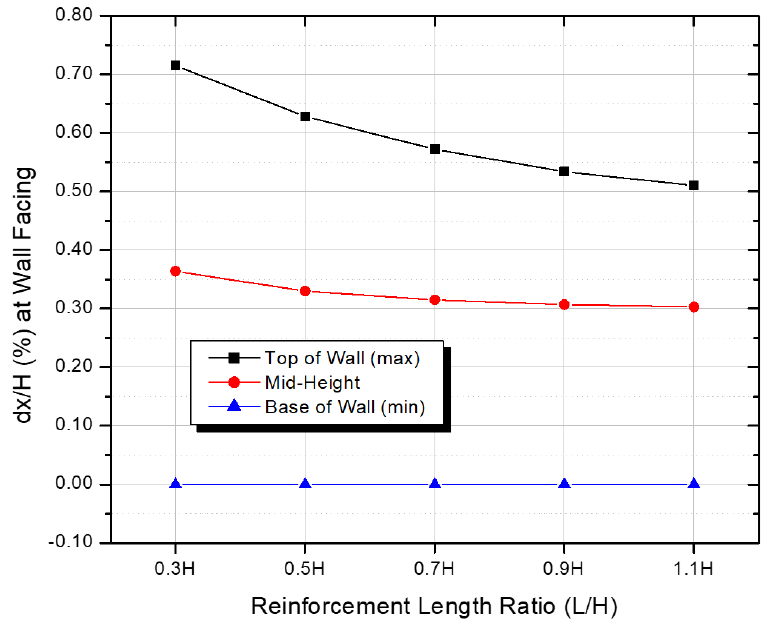
Figure 5. Lateral Displacement Ratio at Wall Facing.